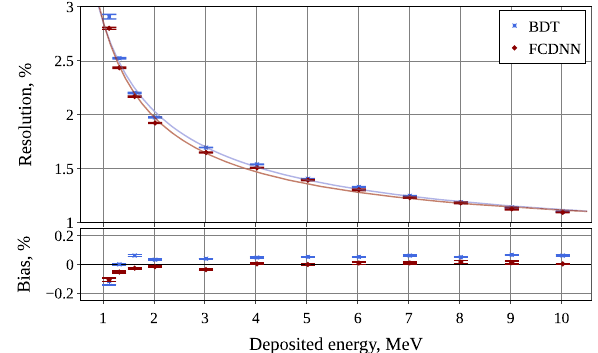
2 σ from the optimal quality corresponding to the feature list above.